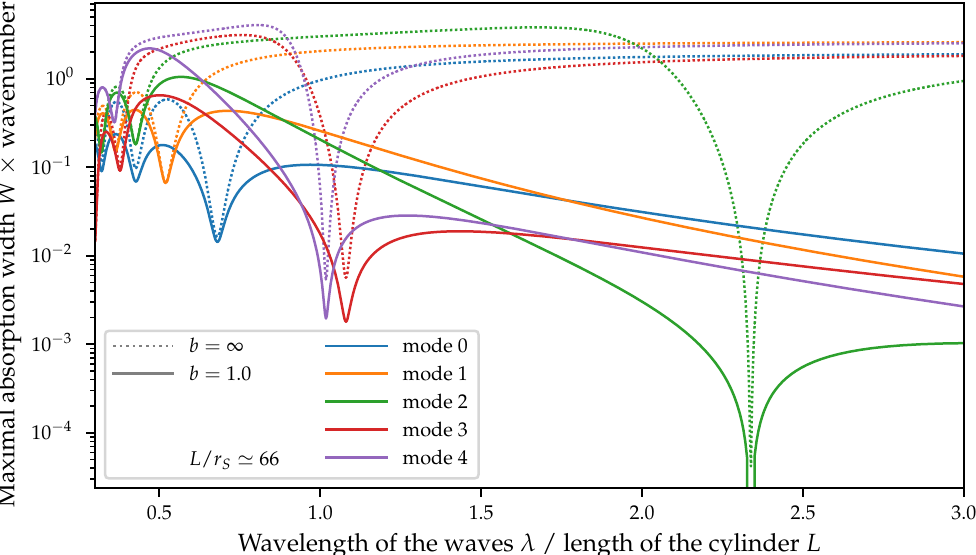
Figure 5. Dimensionless maximal absorption width as a function of the wavelength of the incoming waves. Each line corresponds to the absorption width of the different degrees of freedom of the S3 taken individually. The dotted lines are the unconstrained absorption widths. The solid lines are the absorption width under the constraint b =